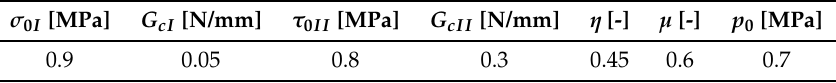
Figure 11. Force vs. slip curve of the experimental and modeled warp yarn pullout test. Table 3. Identified parameters of interface element